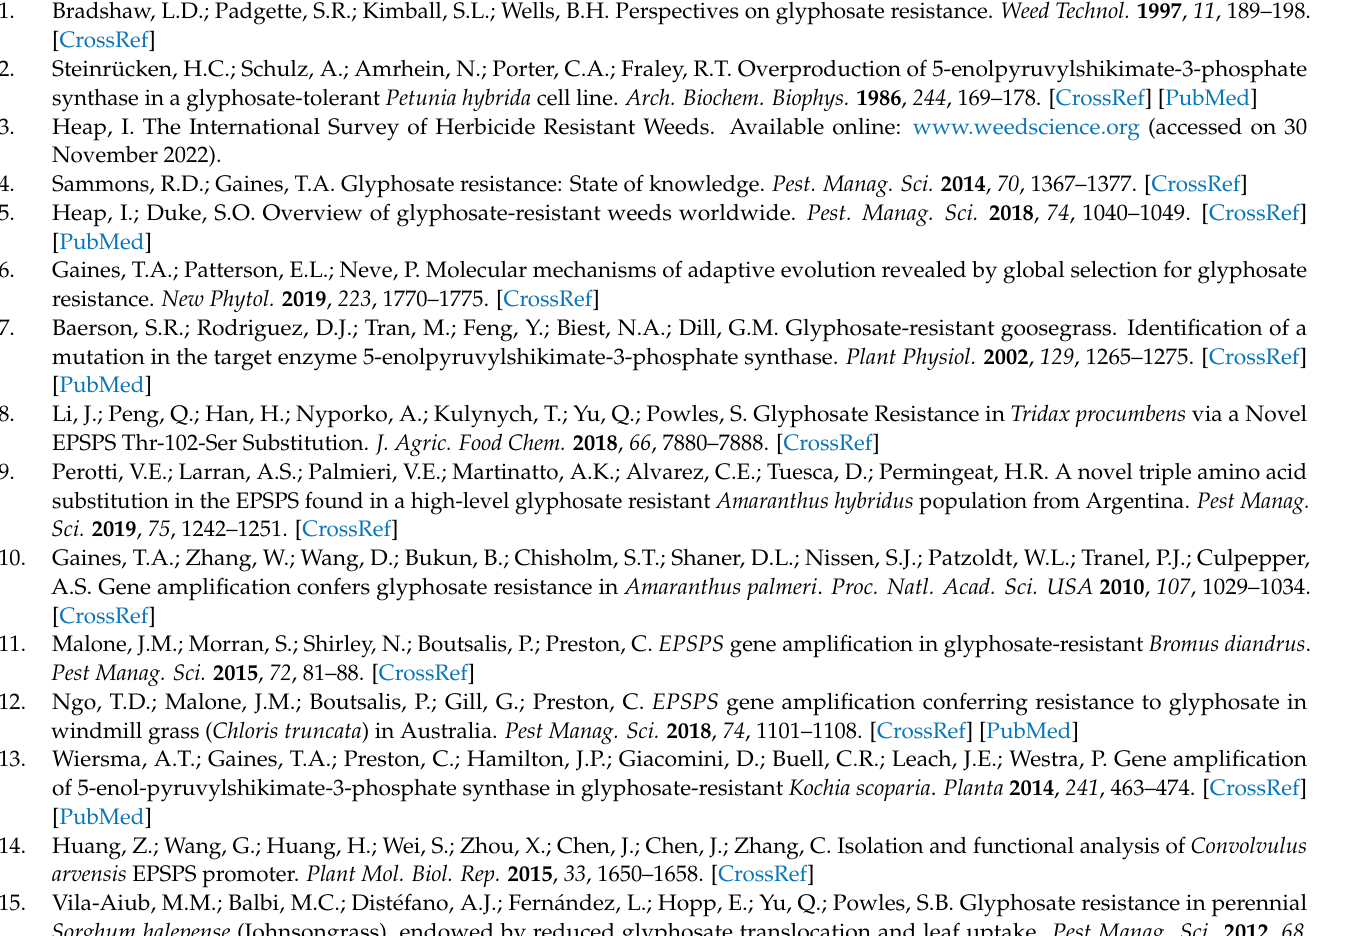
Table S1: The designed primers for EPSPS gene clone, qPCR, and the reference genes for E. indica